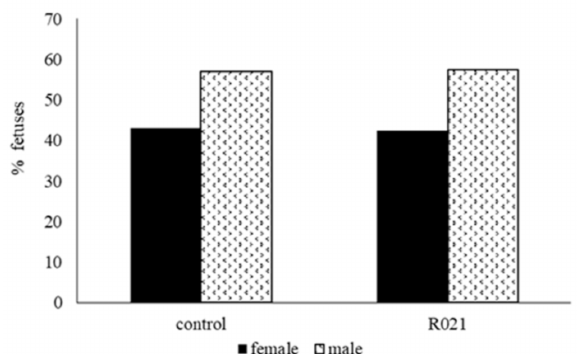
Figure 3. Proportions of females and males at 28 days of gestation from ad libitum fed mothers (Control group; n = 30) and fed restricted females (105 g/day) during the first two-thirds of gestation and re-fed ad libitum until term (R021 group; n = 30). Day 0, day of artificial insemination (AI); length gestation, 31 days.